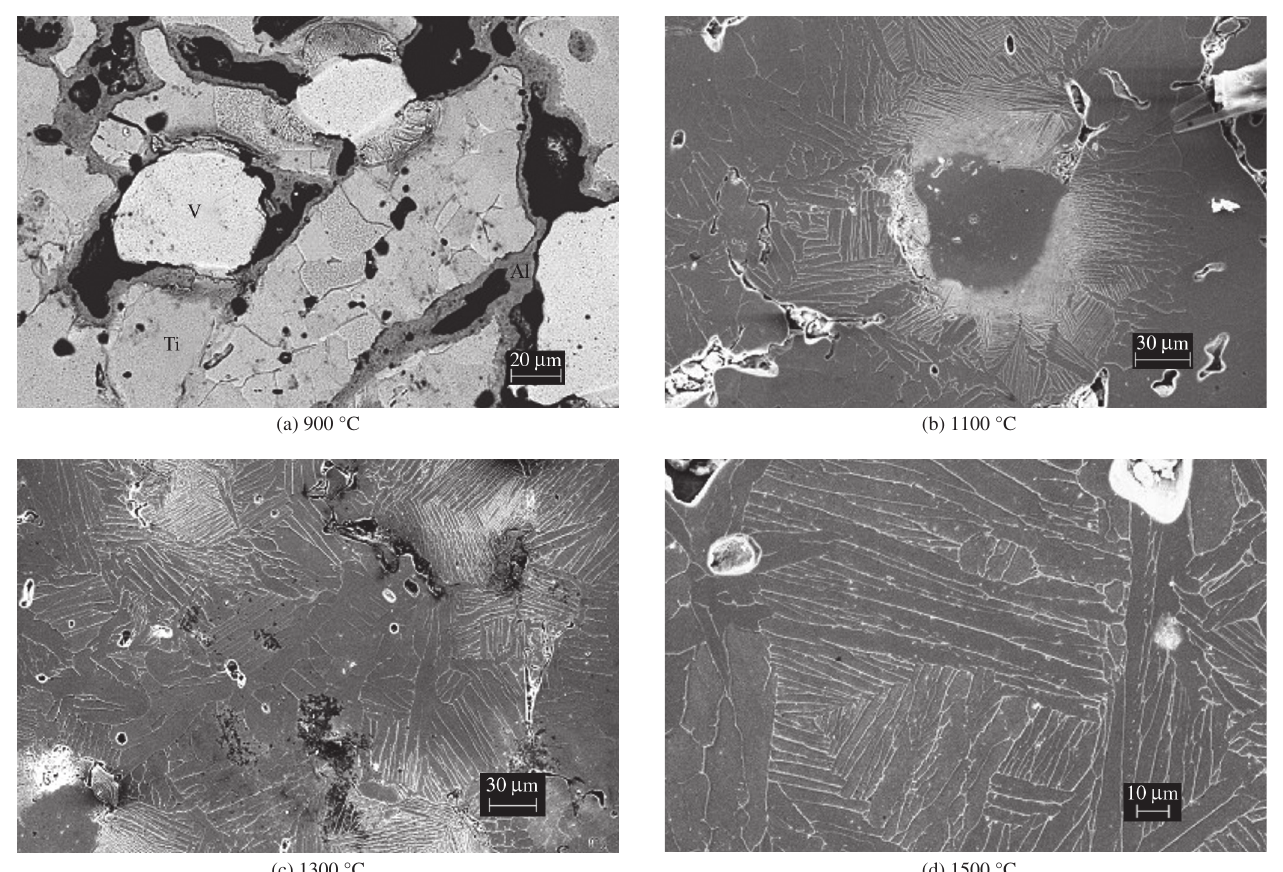
Figure 1. Microstructural development of P/M-Ti-6Al-4V alloy showing the Widmanstätten growing from vanadium dissolution between 900 to 1500